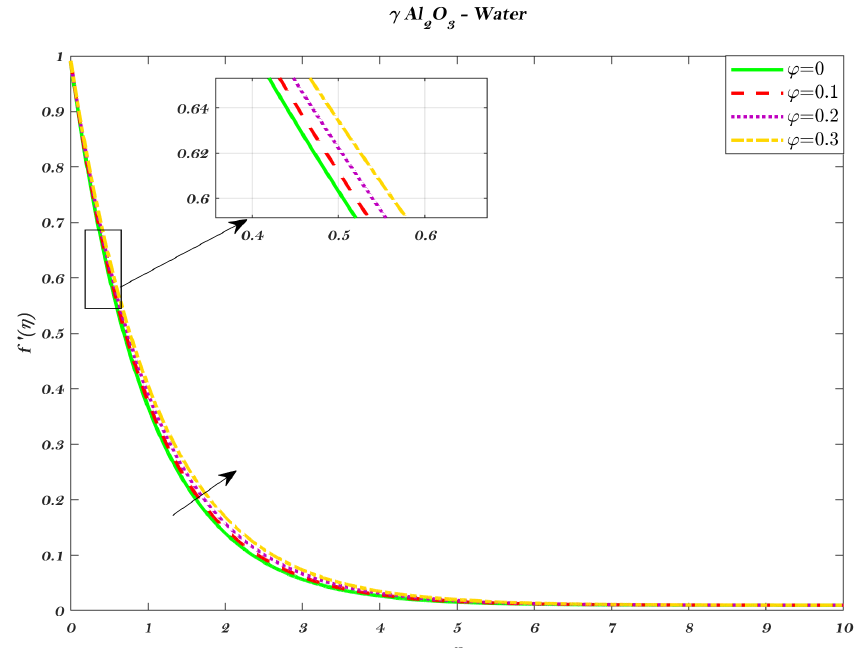
Figure 4. Velocity profile as a function of nanoparticle volume fraction ϕ with fix parameters (cid:101) = 0.02 ˘ a = 0.01 and P r = 6.96.